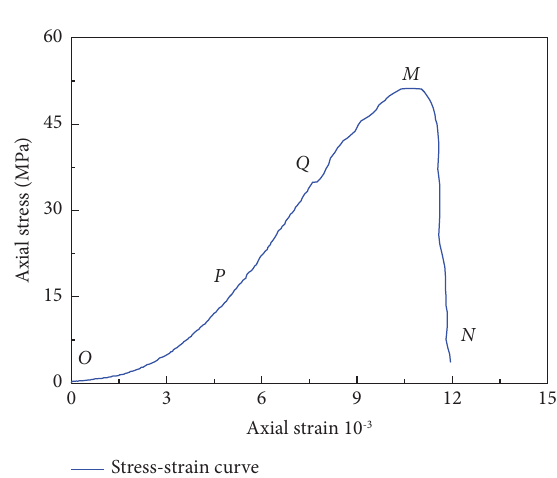
Figure 2: Stress-strain curve of standard